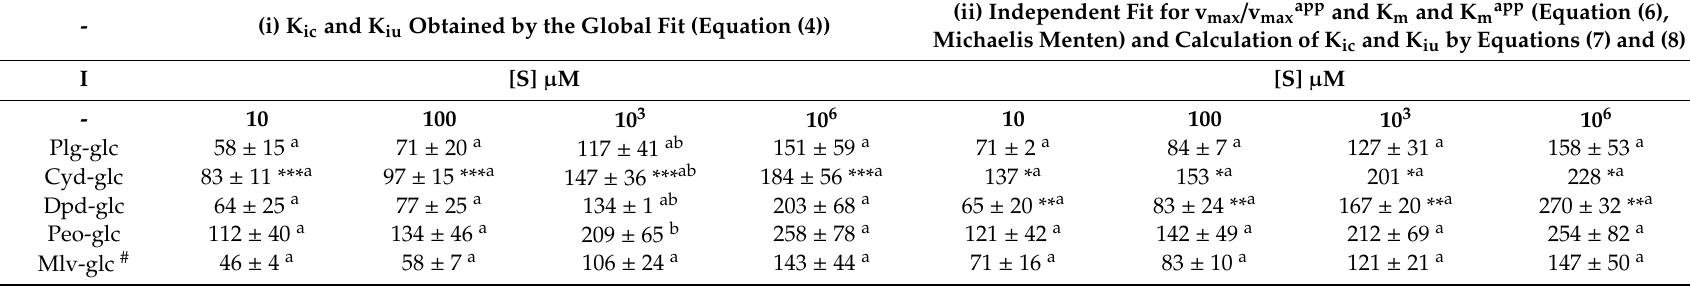
Table 2. IC 50 values for anthocyanin-3-glycosides calculated by Cheng − Prusso ff equation (Equation (9)) with K ic and K iu values obtained by di ff erent